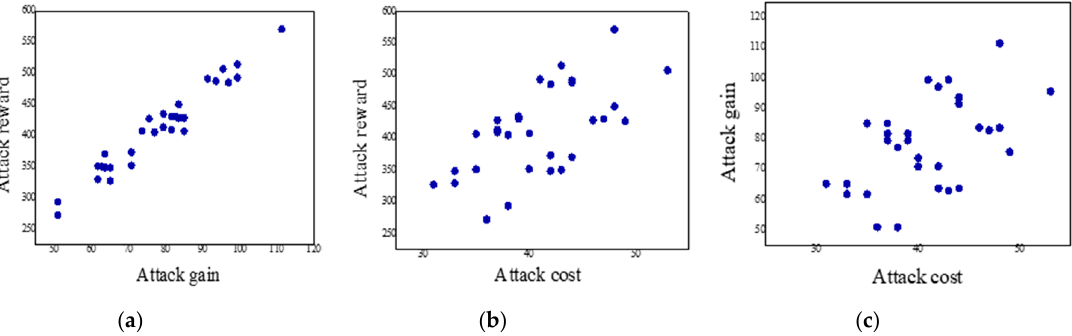
Figure 5. The relationship between attack gain, attack reward, and attack cost in mode 1: ( a ) The relationship of attack gain and attack reward; ( b ) The relationship of attack cost and attack reward; and ( c ) The relationship of attack cost and attack gain.